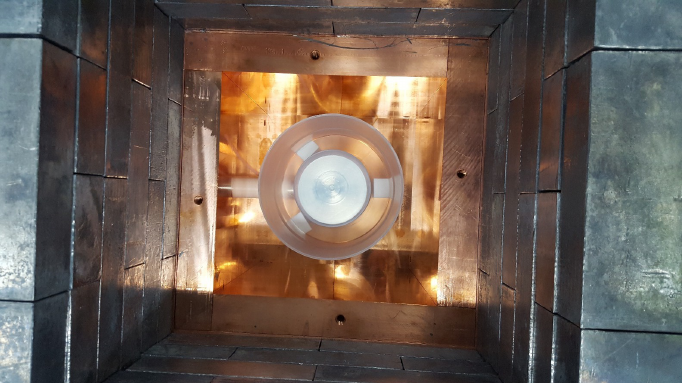
Figure 20. Sample volume inside the Cu